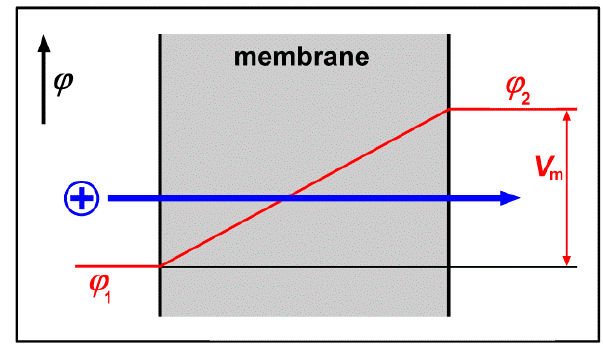
Figure 4. Schematic representation of electrogenic transport. The red line indicates the course of the electric membrane potential, here in case of a homogeneous membrane dielectric. The difference of the electric potentials on both sides, φ 1 – φ 2 , is the membrane potential V m . In cells it is always inside negative. According to basic principles of electrostatics, the movement of a charge, Δ q , from one side of a capacitor to the other alters the electric potential differ- ence, Δ V m = C m ·Δ q , proportionally to the membrane capacitance, C m